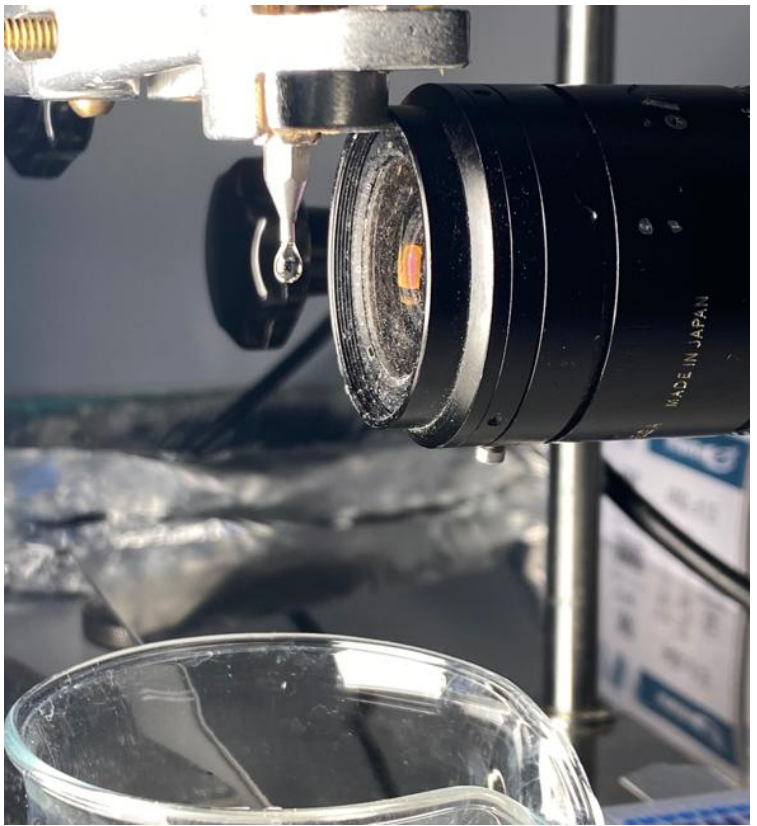
Figure 2. Experimental setup in test: Droplet formed and about to detach from the dropper.